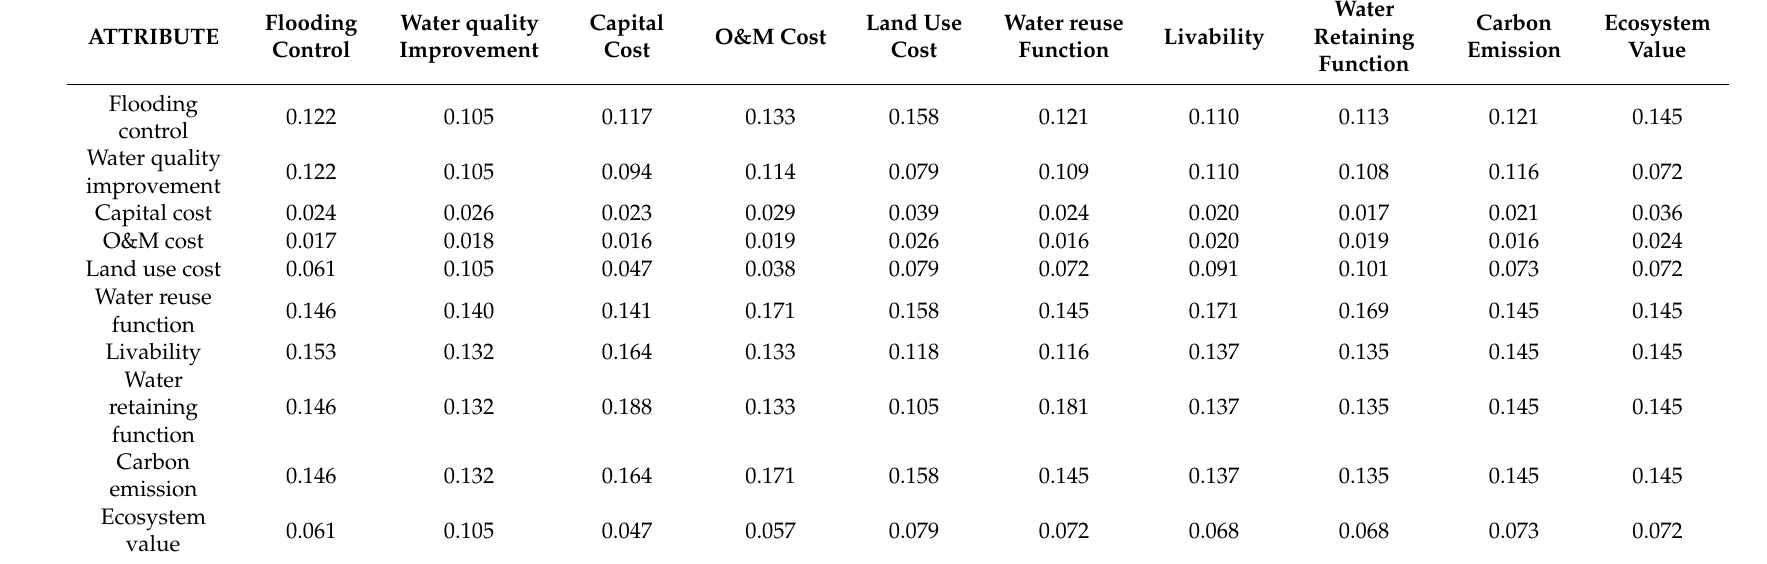
Table A10. Normalized pair comparison